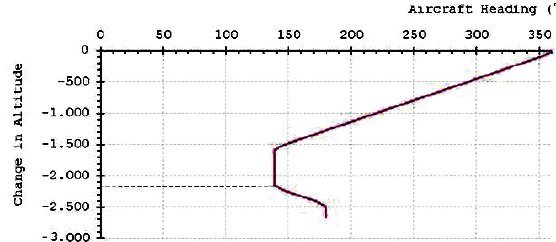
Fig. 5. Change in altitude versus aircraft heading over the optimum landing